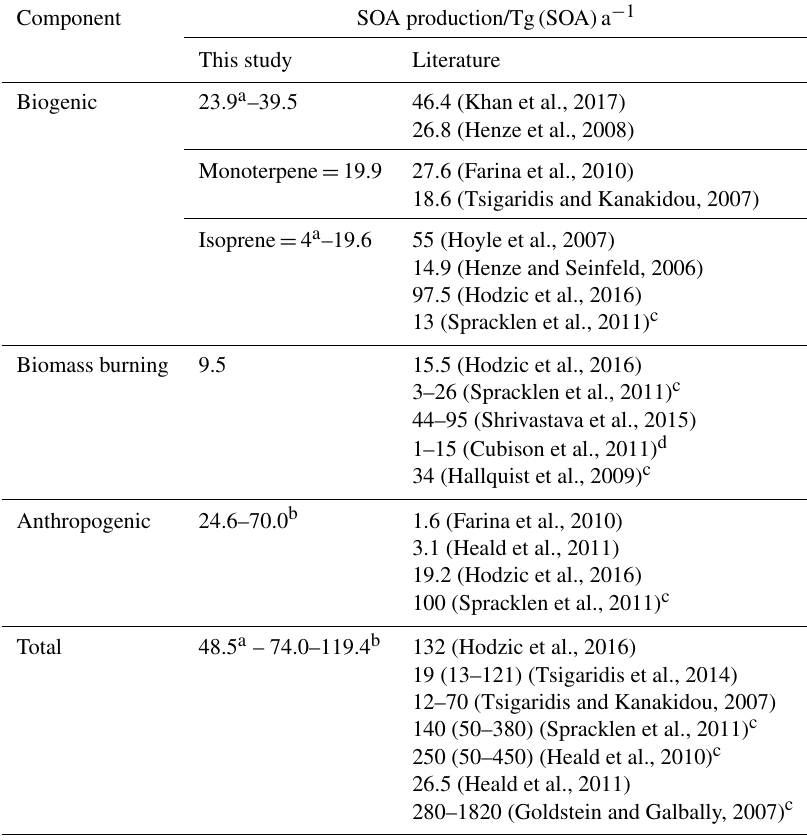
Table 3. Global annual SOA production from this study and the literature (Tg (SOA)a − 1 ). In this study, estimates derived from the isoprene (Iso (3%)) and anthropogenic (Ant (40%)) sensitivity simulations in this study are indicated. All remaining estimates from this study are based on simulations using identical reaction yields of 13%. From the literature, estimates derived from top-down and observation methods are indicated. The remaining estimates form the literature are based on bottom-up